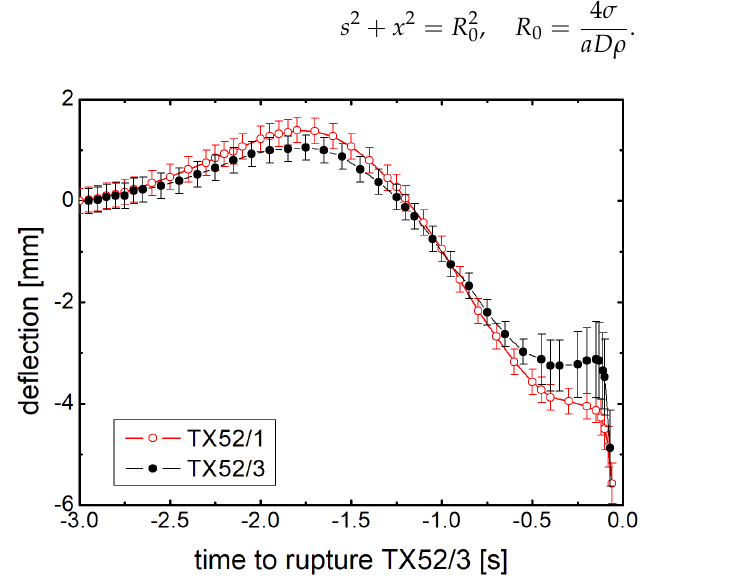
Figure 7. Deflection of two columns with aspect ratios of between 4.5 and 4.75 during the decelera- tion of the TX52 rocket (we measured the lateral displacements of the columns at their maximum deflections relative to the initial straight columns).